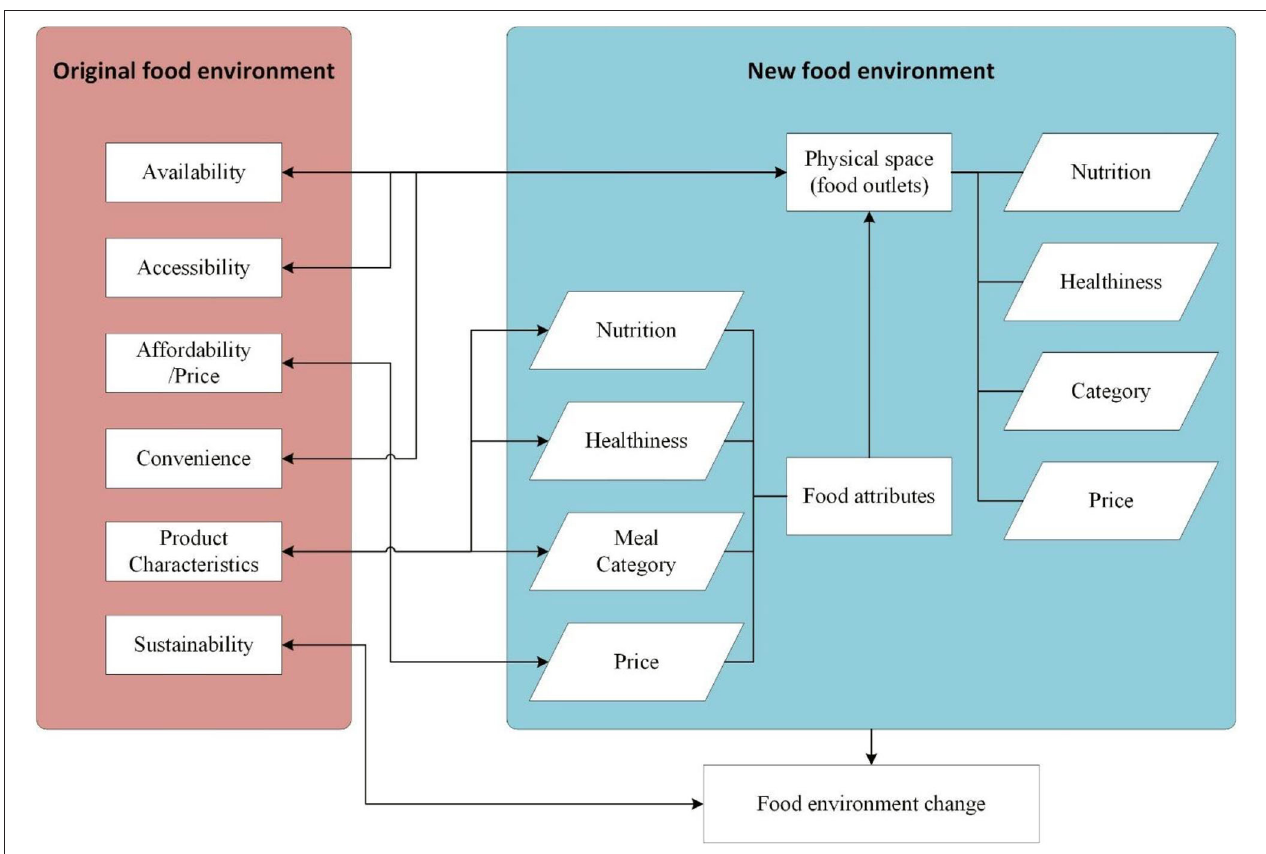
FIGURE 3 | The transformational relationship among dimensions of the original food environment and the new food